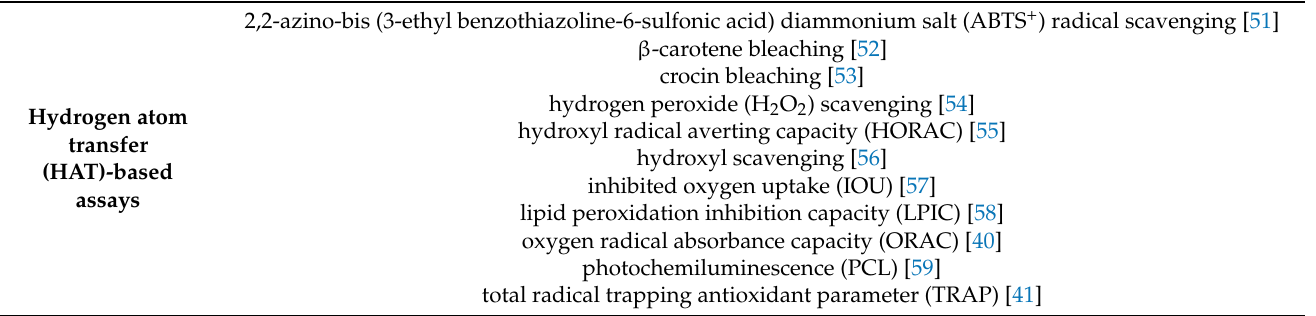
Table 1. A list of the most commonly used in vitro assays for the determination of antioxidant activity (adapted from [50]).